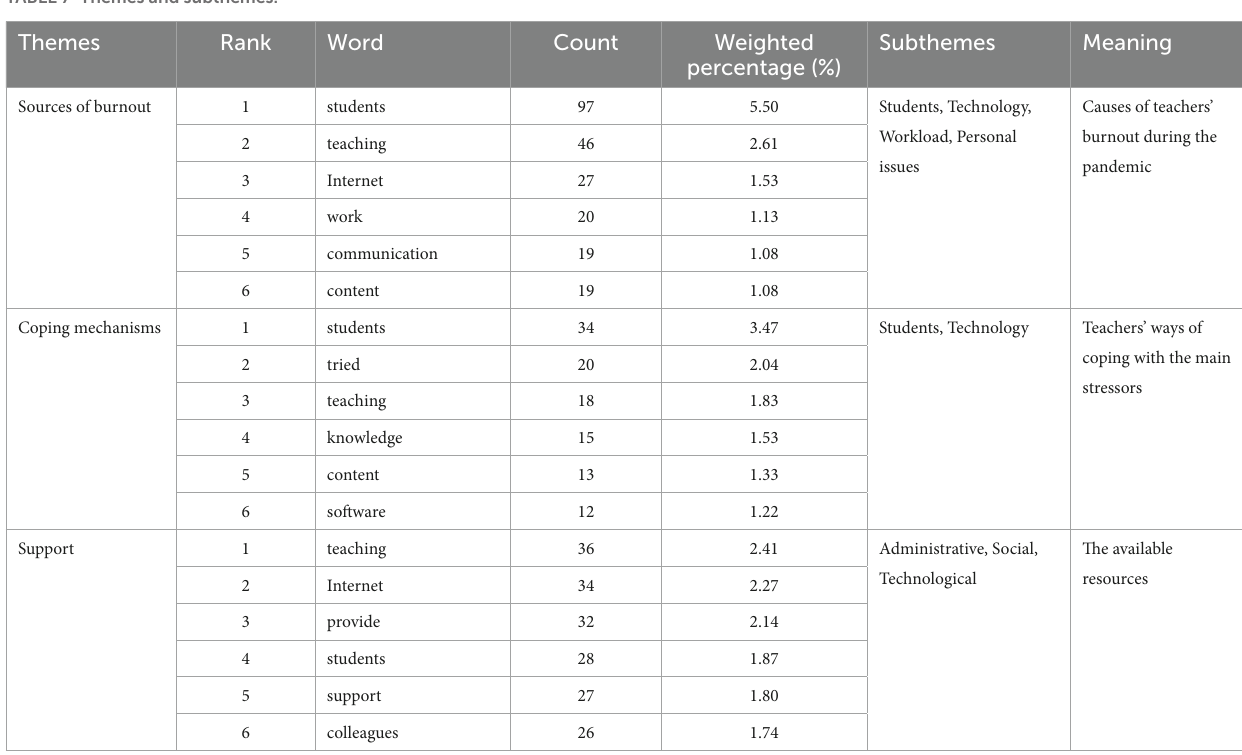
TABLE 7 Themes and